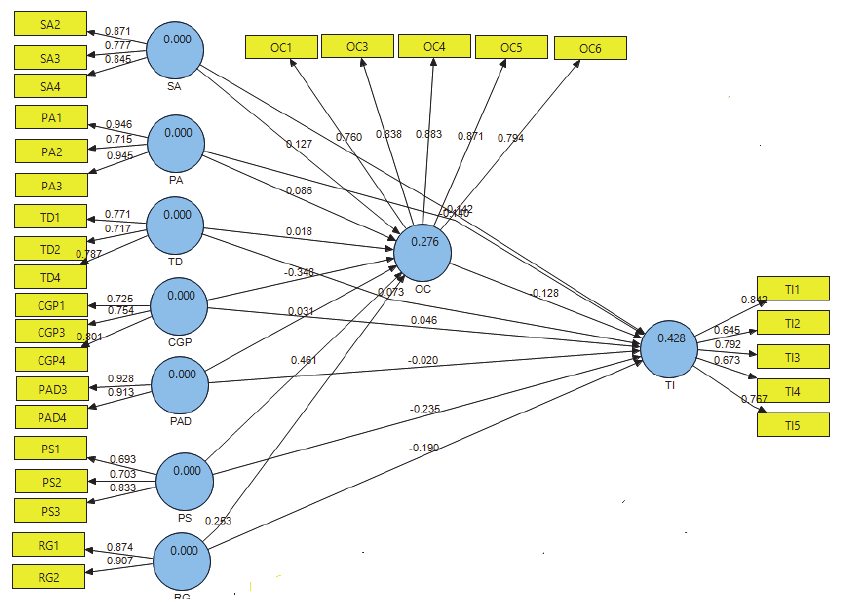
Fig.1. Measurement Model of the Study